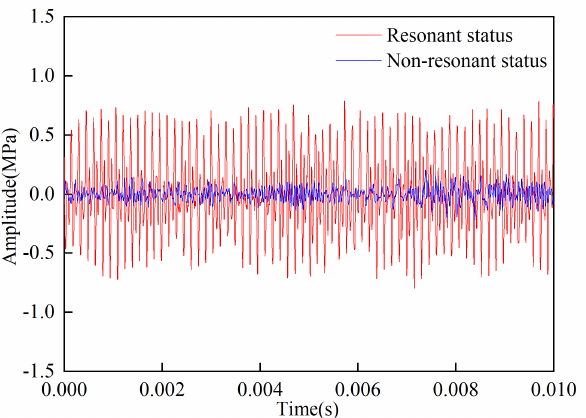
Figure 3. Time-dominant pressure fluctuation characteristics of the self-excited